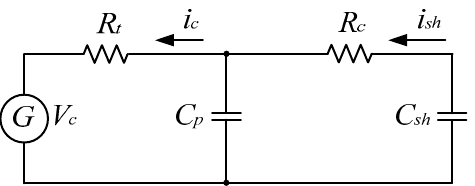
Figure 6. Electrical transmission line equivalent circuit diagram for modeling heat conduction properties; the physical variables are specified in their thermal equivalents.